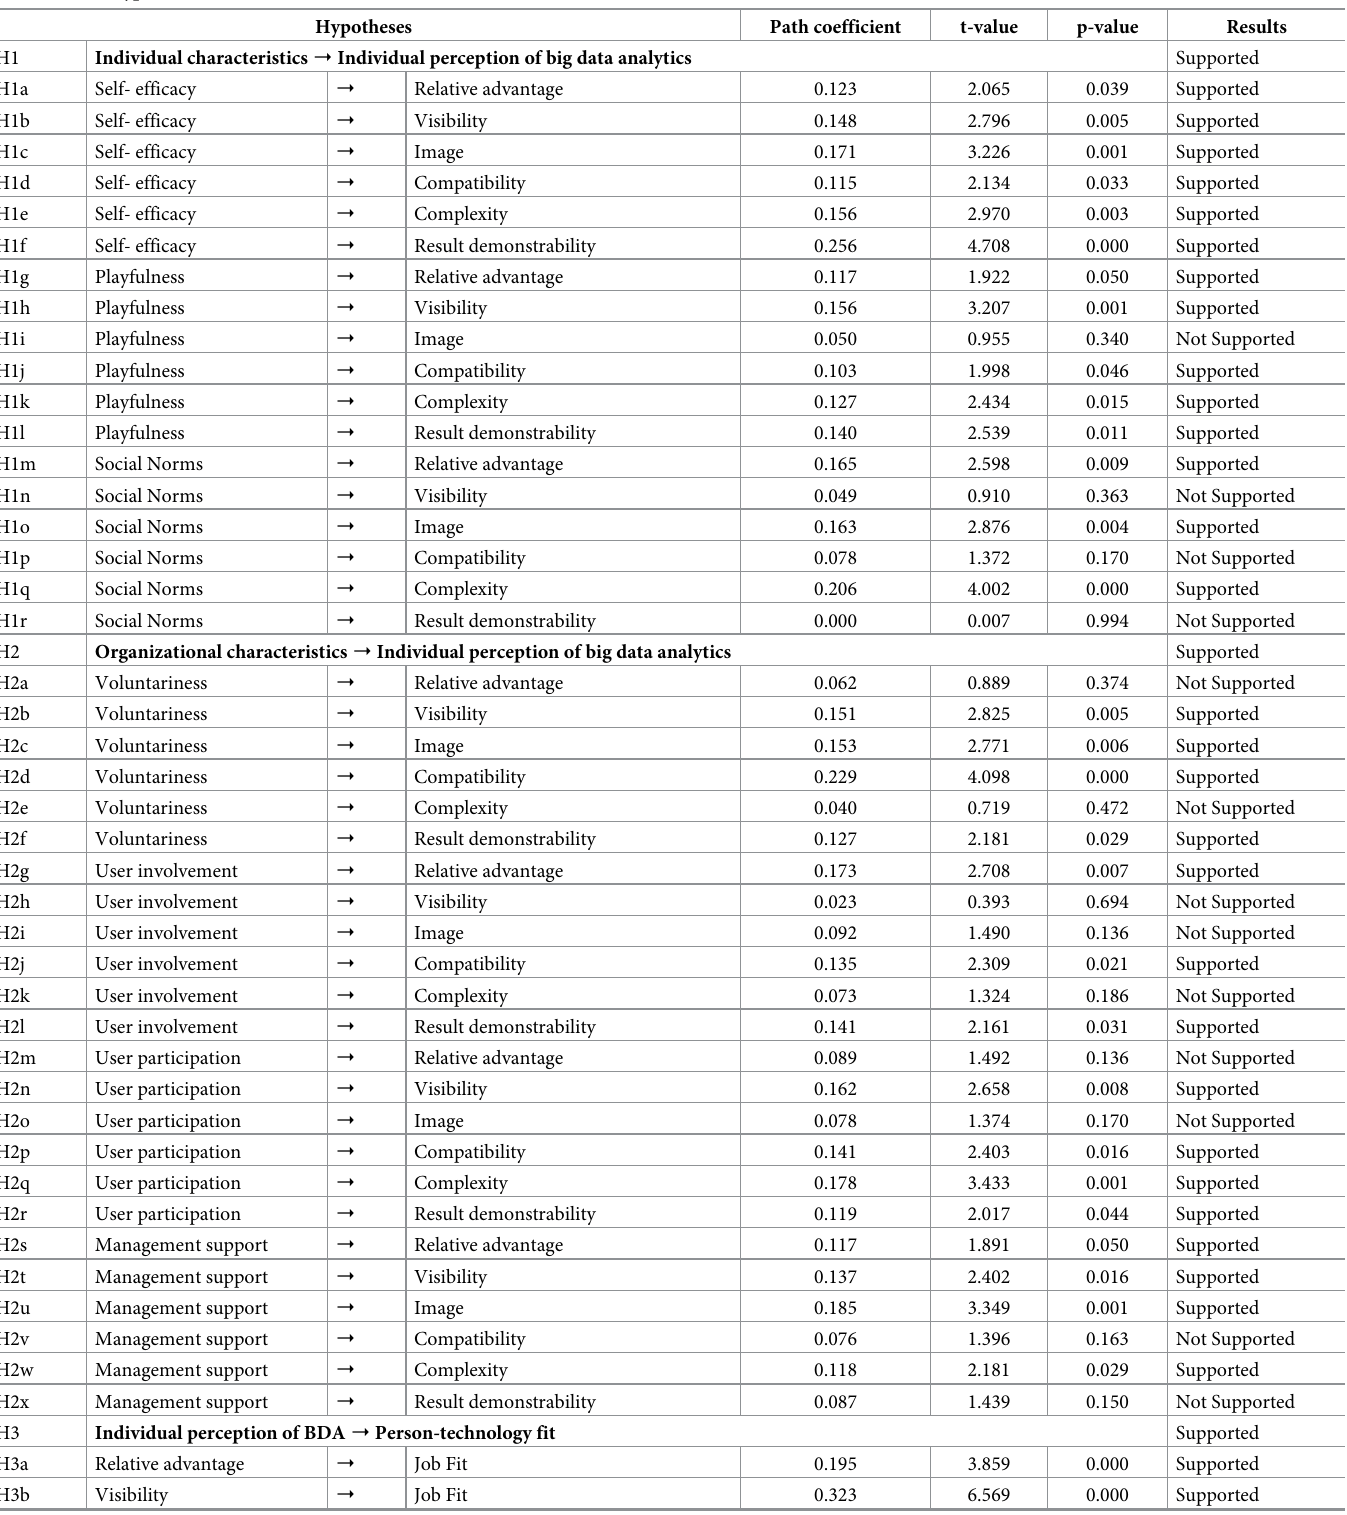
Table 5. SEM hypotheses